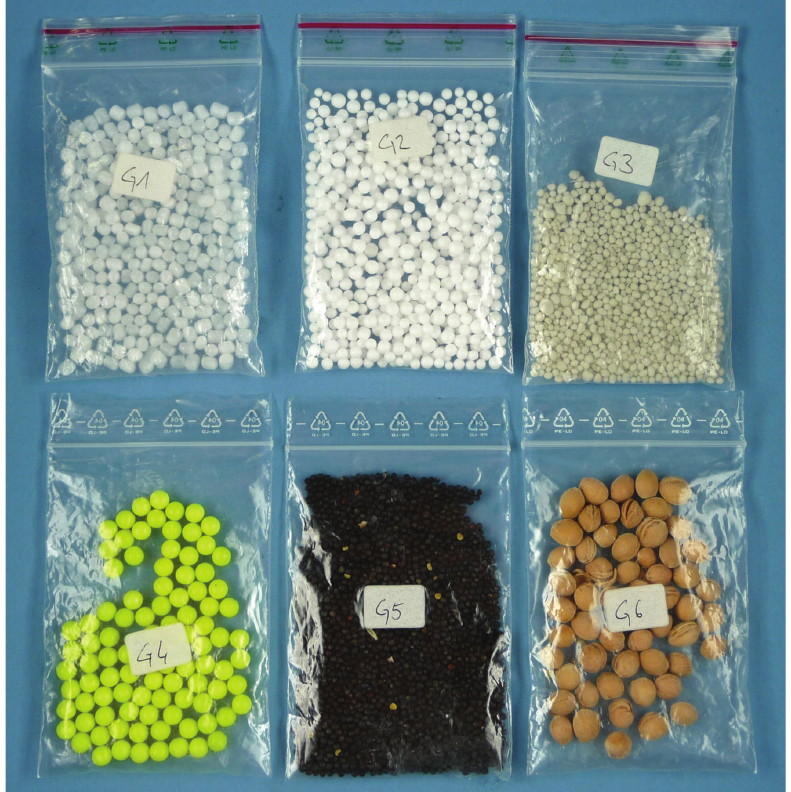
Figure 6 Selection of granules: from top left: EPP, EPS, expanded glass, ABS, rape seeds, cherry pits.